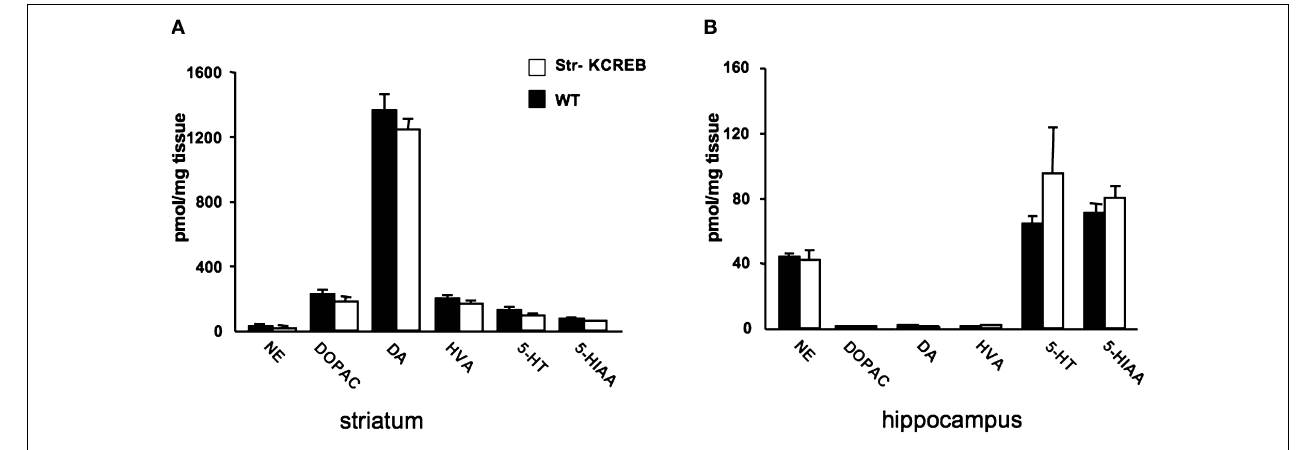
FIGURE 4 | str-KCREB animals have normal levels of dopamine, its metabolites, and other monoamines, in striatum and hippocampus. Striata and hippocampi were dissected from str-KCREB and littermates controls, and the tissue was assayed by HPLC for modulatory monoamine transmitters and their metabolites. No signifi cant differences were seen between str-KCREB